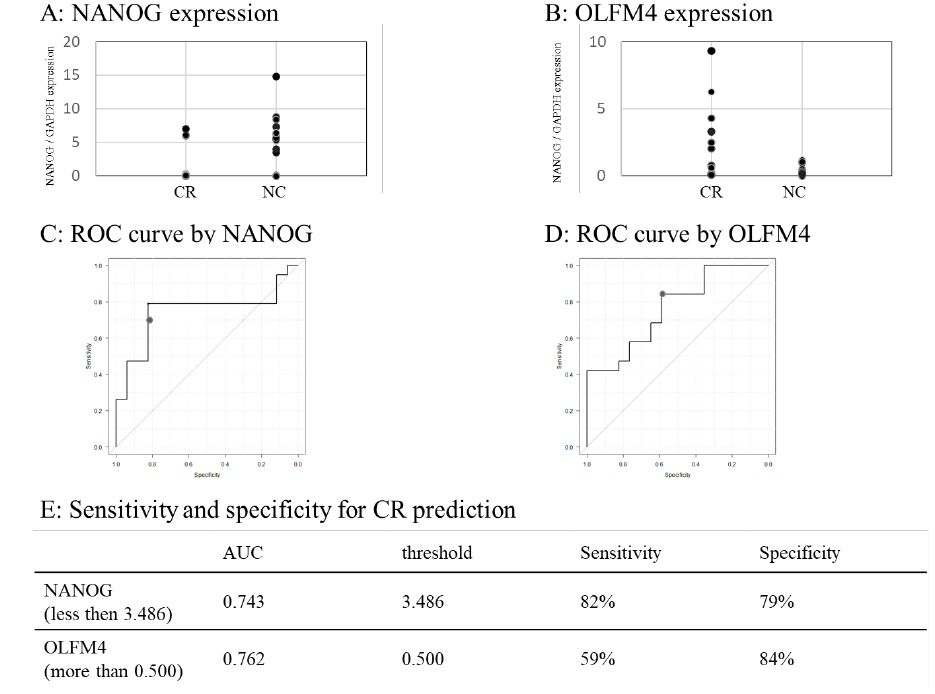
Figure 4. Predictability of NANOG and OLFM4 for CR. ( A , B ) Dot chart showing the NANOG ( A ) and OLFM4 ( B ) expression in the CR and NC groups. ( C , D ) ROC curves generated from NANOG expression value to predict CR ( C ) and OLFM4 ( D ). ( E ) Predictability of NANOG (less than threshold determined with the Youden index) and OLFM4 (more than threshold determined with the Youden index) to predict CR. ROC, receiver operating characteristic.